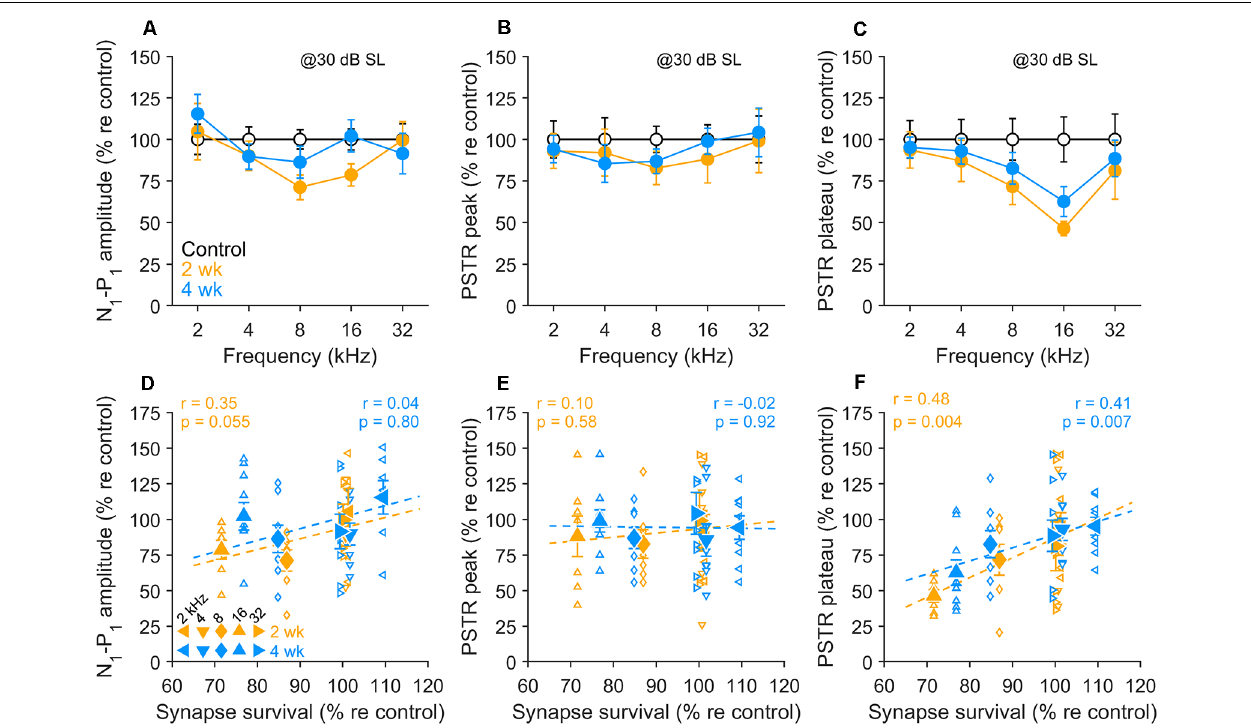
FIGURE 6 | Correlations between electrophysiological indices and synapse survival. (A–C) N1-P1 CAP amplitude (A) , PSTR peak (B) , and PSTR plateau (C) in unexposed and exposed gerbils 2 wk and 4 wk after noise. Means ( ± SEMs) are normalized to unexposed group values. CAP and PSTR measured at 30 dB above PSTR threshold. (D–F) Individual data (small symbols), group means (large symbols), and linear fits (dashed lines) for 2- and 4-wk held animals compared to control, for the electrophysiological indices shown in panels (A–C) and synapse survival data shown in Figure 3 . Means are ± SEM, n = 4 animals/group. Correlations were tested using the Pearson correlation coefficient; r and p -values are given on the individual panels (D–F)